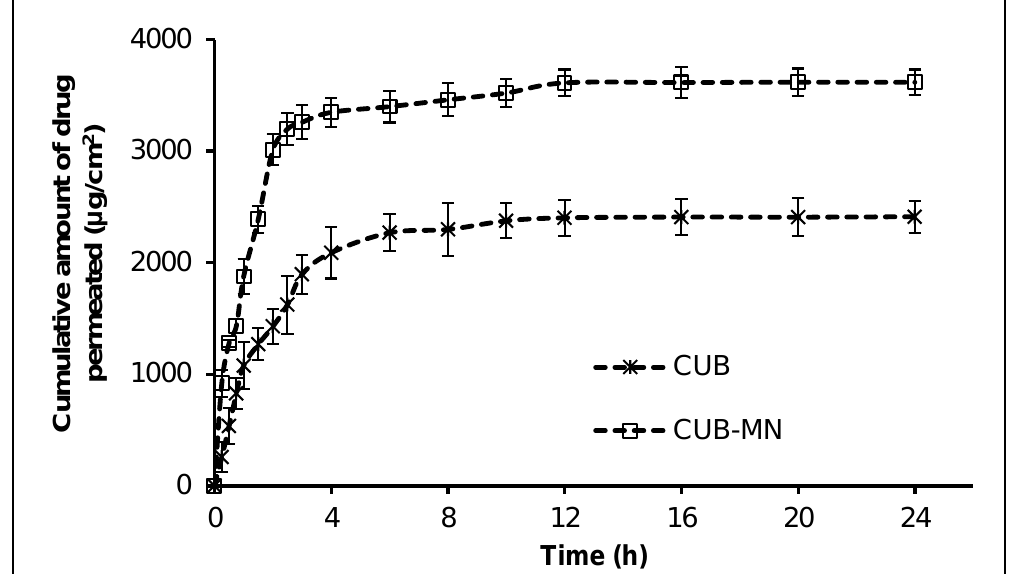
Figure 6. In vitro release of β - ST from CUBs and CUBs - MN D .